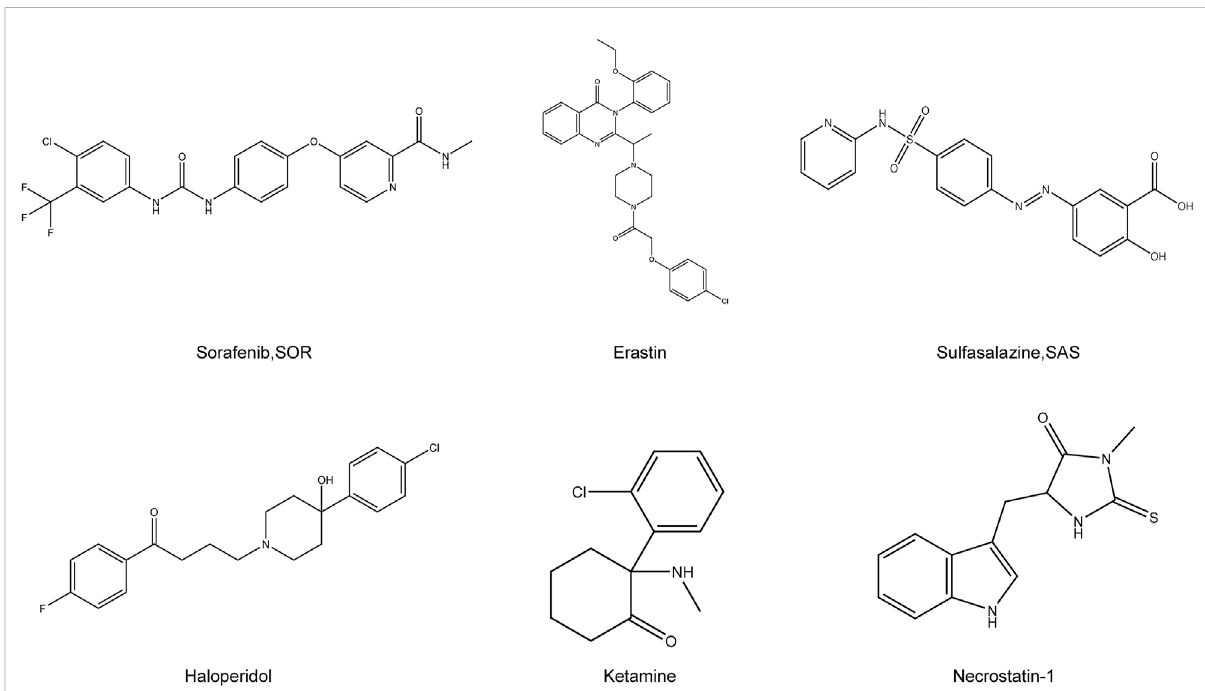
FIGURE 2 Chemical structure of drugs related to the treatment of HCC by ferroptosis. Structural formula of some compounds that can target ferroptosis to inhibit HCC. Sorafenib, SOR; Sulfasalazine,